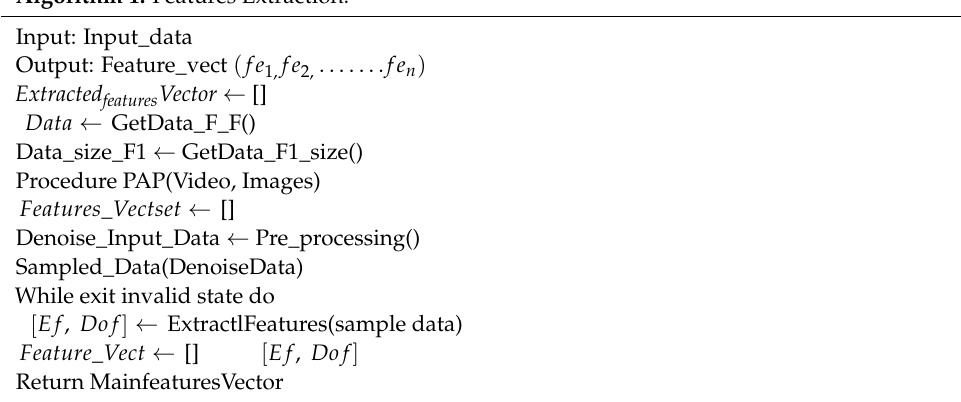
Algorithm 1. Features